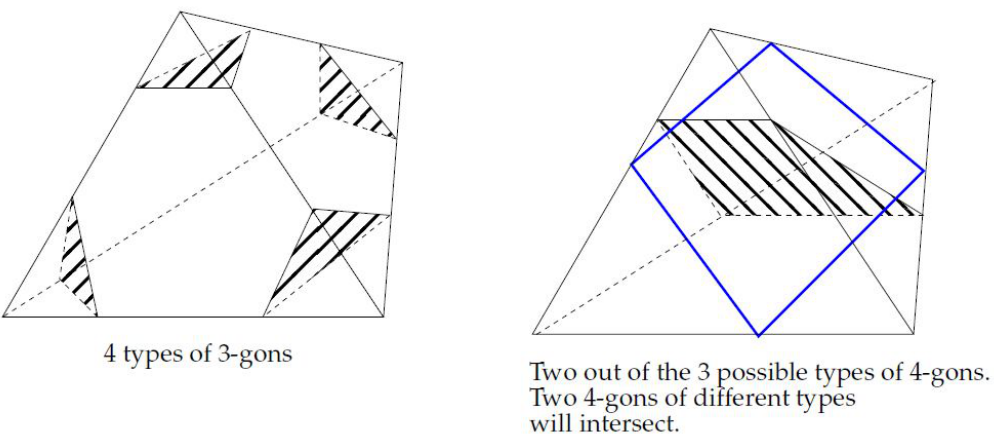
Figure A1. Elementary disks.